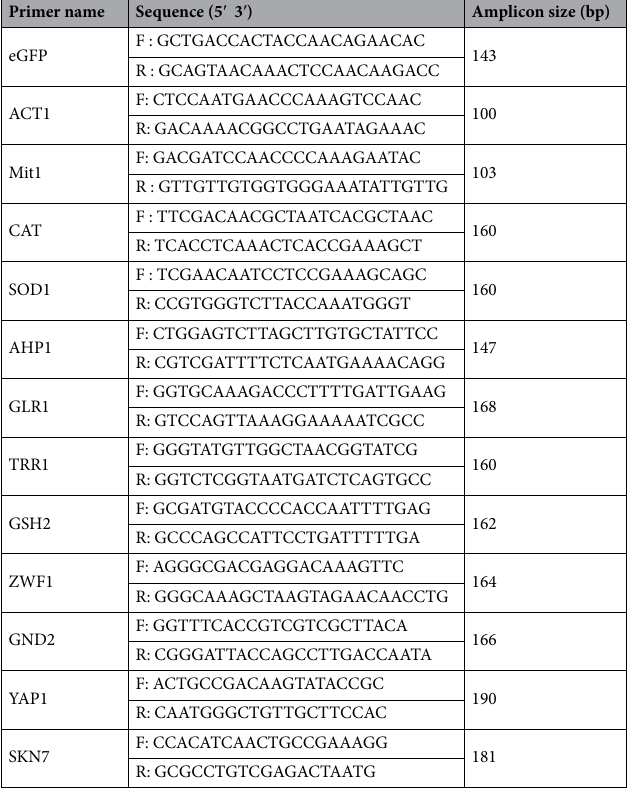
Table 2. List of primers used in this